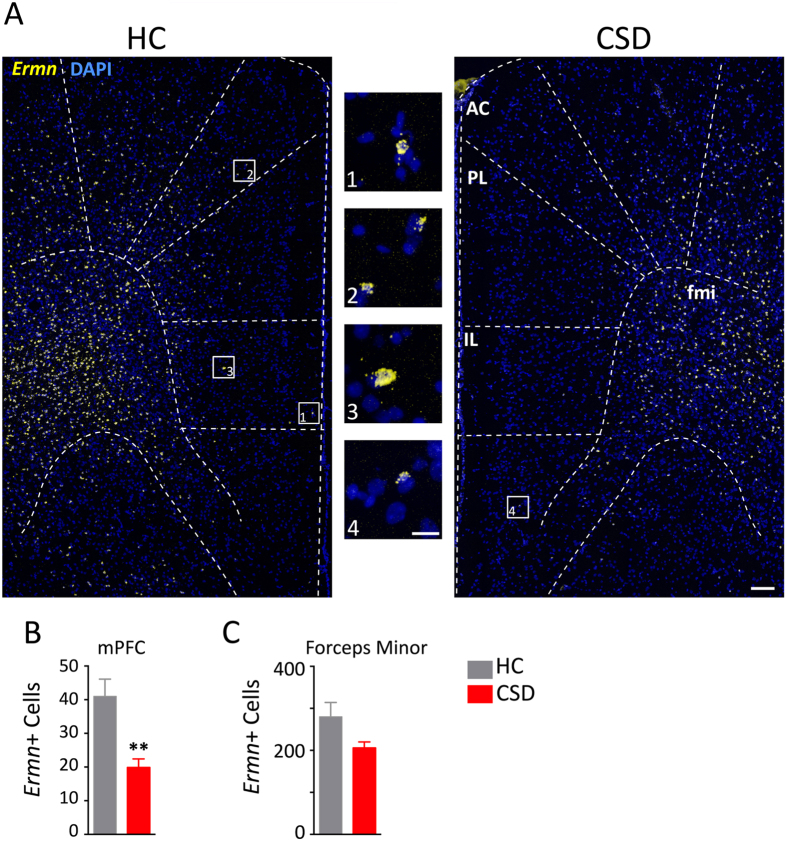
CSD reduced the expression of ermin (Ermn) mRNA.(A) Representative fluorescent micrographs of Ermn expression show comparative differences between HC and CSD frontal cortices. Dashed lines indicate anatomical regions and templates within which counts were made. The medial prefrontal cortex (mPFC) was defined by the anterior cingulate (AC), prelimbic (PL), and infralimbic (IL) cortices. fmi, forceps minor corpus callosum. Scale bars = 100 μm and 20 μm for low- and high-magnification photographs, respectively. (B) CSD significantly reduced the number of Ermn-positive cells in the mPFC. (C) Stress effects on Ermn expression in the fmi approached significance (p = 0.061). Results are expressed as mean ± SEM (n = 5 per group). Unpaired two-tail t-test: *p < 0.05, **p < 0.005.